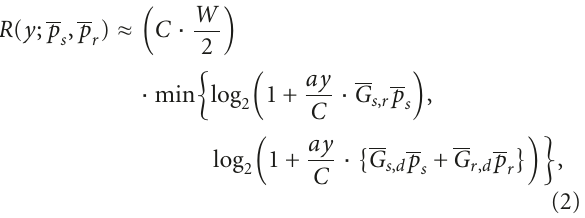
Figure 2: An example of frame structure (in the time domain) for decode-and-forward relaying. The first slot is used for source node to transmit whereas the second slot for relay node to relay the received data from the source